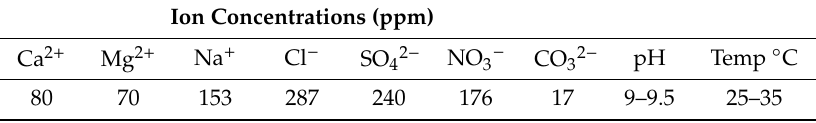
Table 2. Physicochemical properties of a typical South African platinum mine processing plant